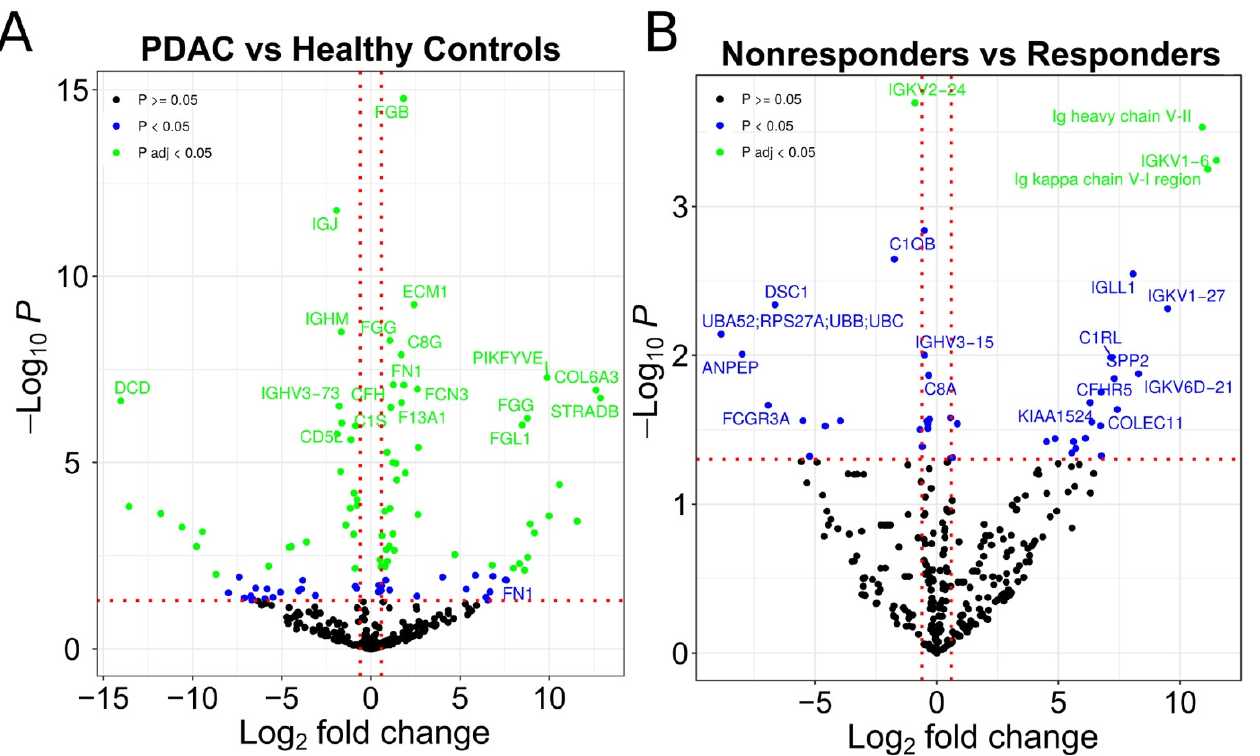
Figure 2. Proteins differentially expressed in EVs. ( A ) Volcano plot representing the identified proteins in MS (comparison between patients (PDAC) and healthy control samples). ( B ) Volcano plot representing the identified proteins in mass spectrometry (comparison between patients that are nonresponders and responders to chemotherapy). The green points represent proteins significantly regulated after correction for multiple testing. The blue points represent proteins significantly regulated without correction for multiple testing. The black points represent proteins with insignificant regulation.